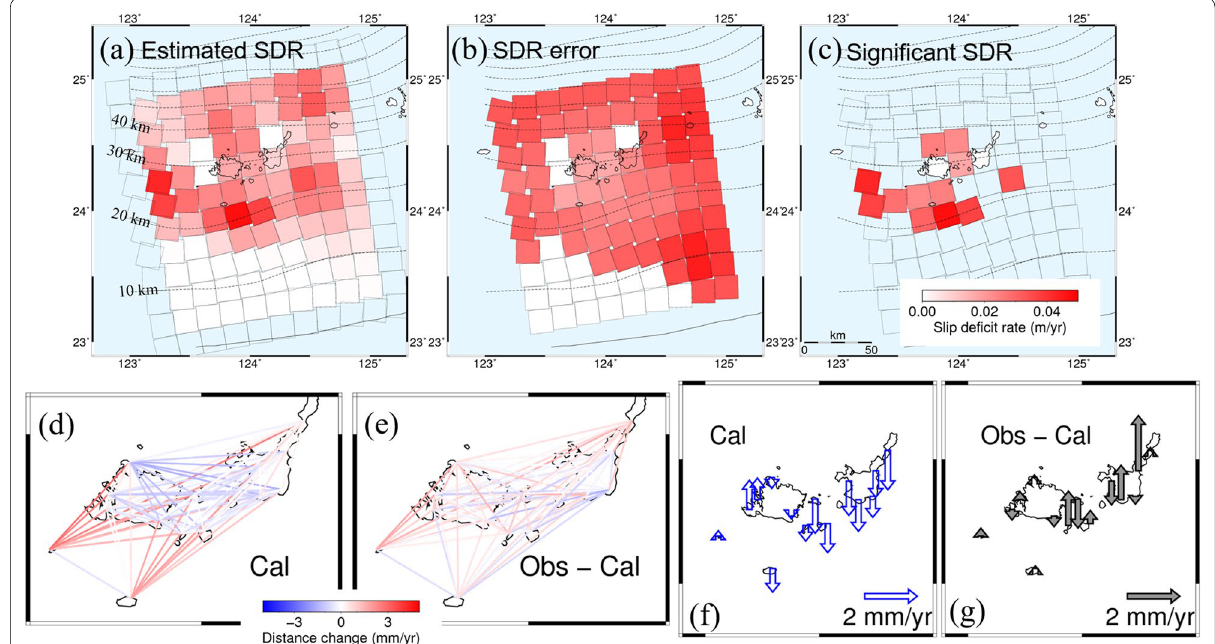
Fig. 3 Estimation of slip deficit rates (SDR) and comparison with observations. a Spatial distribution of SDRs and b their estimation error. c Same as a but only for subfaults whose SDR is greater than the estimation error shown. Note that the additional subfaults imposing zero SDR are shown only in a . The solid and dashed lines are the Ryukyu Trench and the depth contours of the upper surface of the subducting PH with an interval of 10 km (Slab 2) (Hayes et al. 2018). d Calculated distance changes and e residual distance changes. f Calculated and g residual vertical